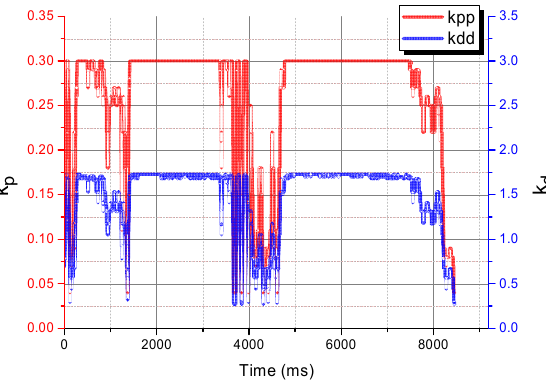
Figure 16. PID gain parameter tendency chart after modulation by DRL-Fuzzy-PID controller. ( a ) k p , ( b ) k d .